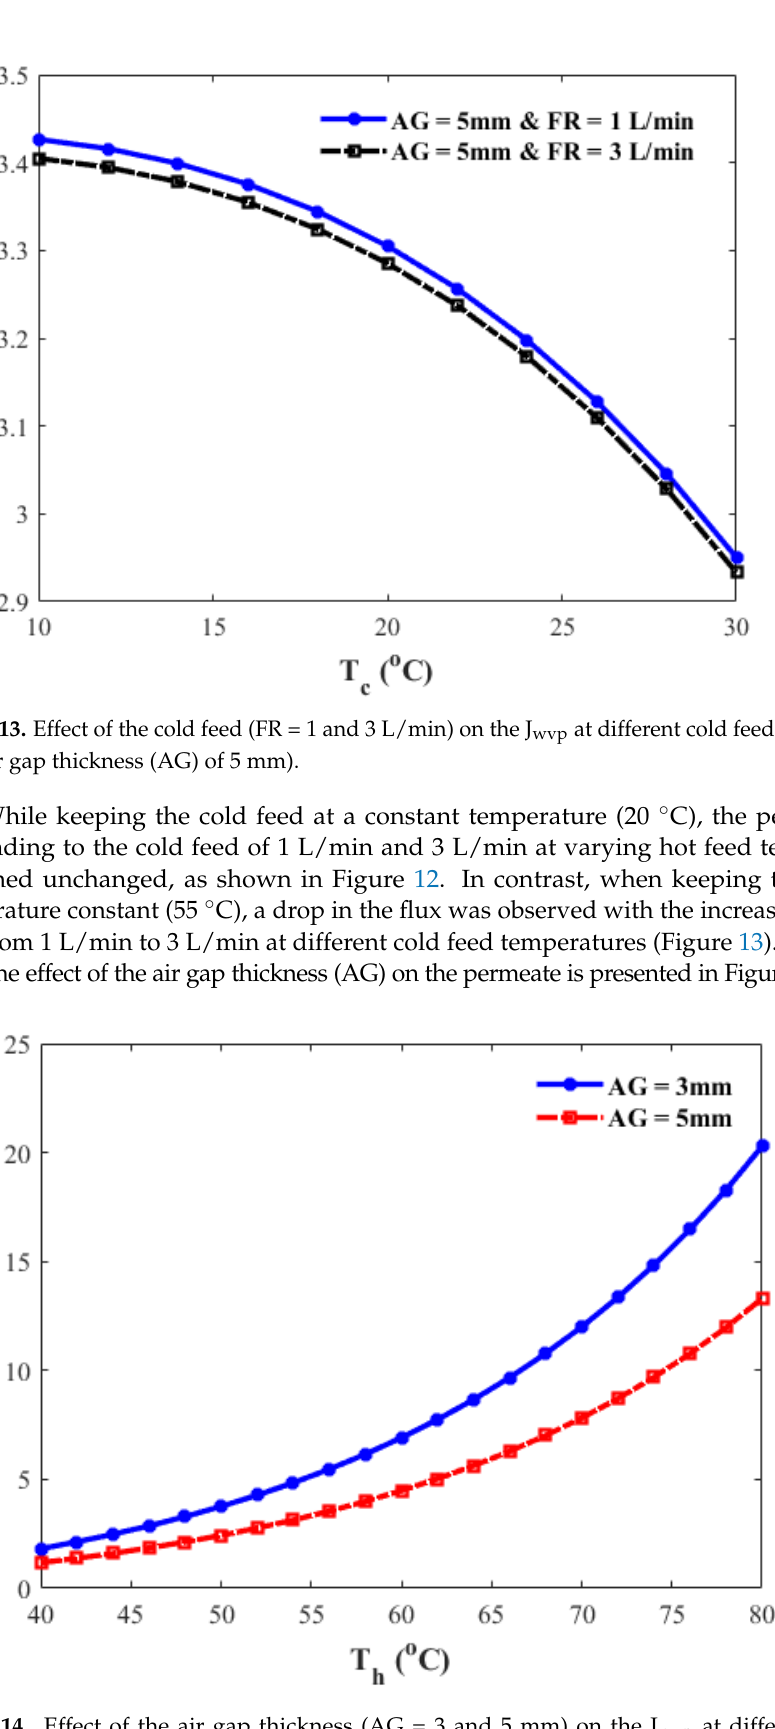
Figure 14. Effect of the air gap thickness (AG = 3 and 5 mm) on the J wvp at different hot feed temperatures (T h ) (hot feed of 2 L/min and cold feed of 1 L/min).